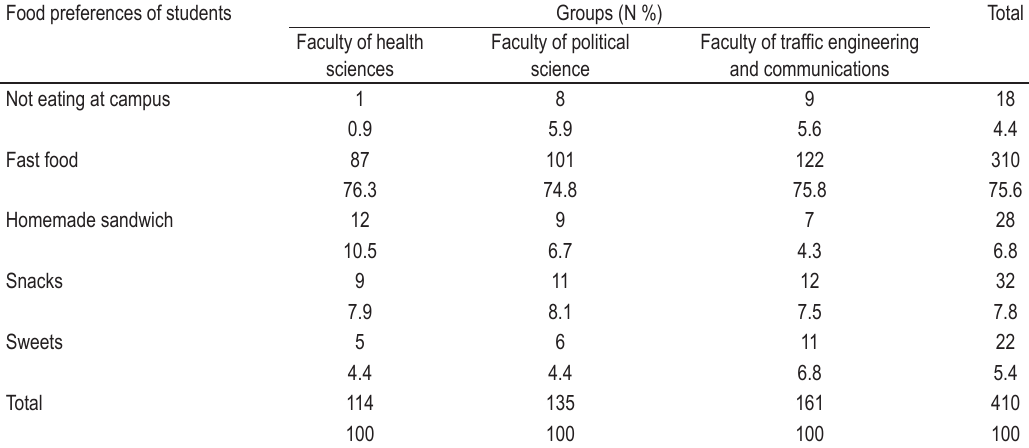
TABLE 7. Food choices of students while at campus Food preferences of students Groups (N %)